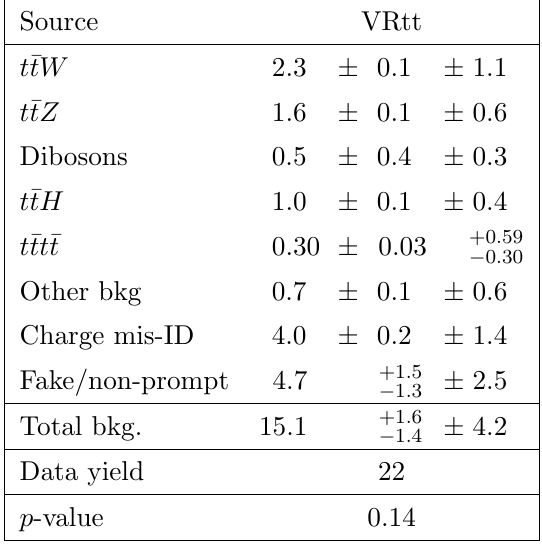
Table 7 . Expected background and observed event yields in the validation region for the same-sign top-quark pair production search. The ‘Other bkg’ category includes contributions from all rare SM processes listed in section 6. The (cid:12)rst uncertainty is statistical and the second is systematic. The p -value is the probability for the expected background to (cid:13)uctuate to equal or exceed the observed